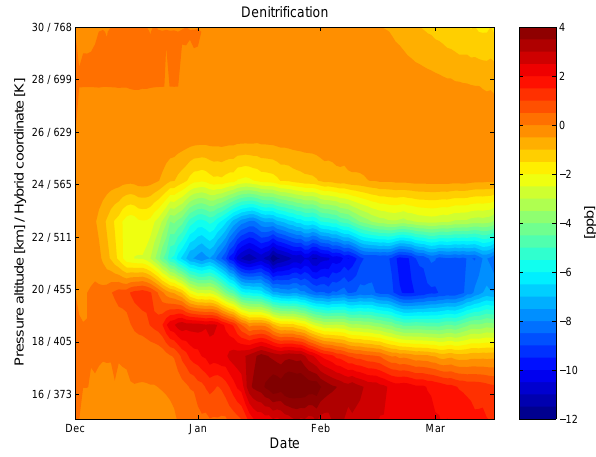
Fig. 5. Vortex-averaged denitrification as the difference of the pas- sive NO y tracer and modeled NO y , averaged as in Fig. 2.